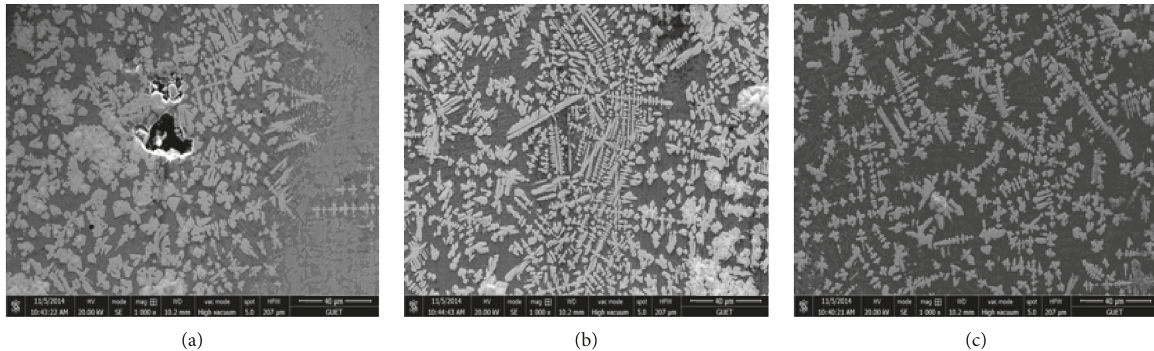
Figure 3: Microstructure of coating cross section with different beam current: (a) 80mA, (b) 83mA, and (c) 85